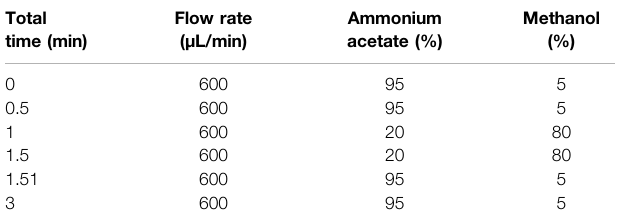
TABLE 2 | The gradient elution of mobile phase of chromatography. Total Flow rate time (min)